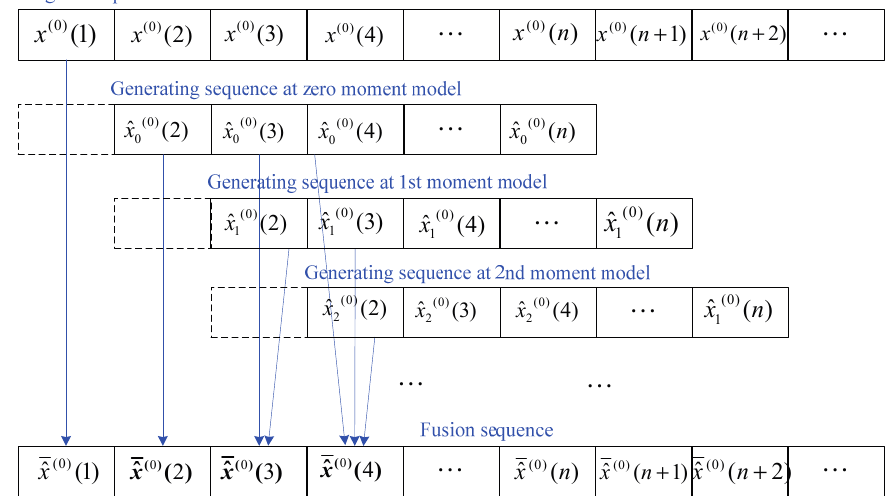
Figure 3. Fusion processing for generating sequences.